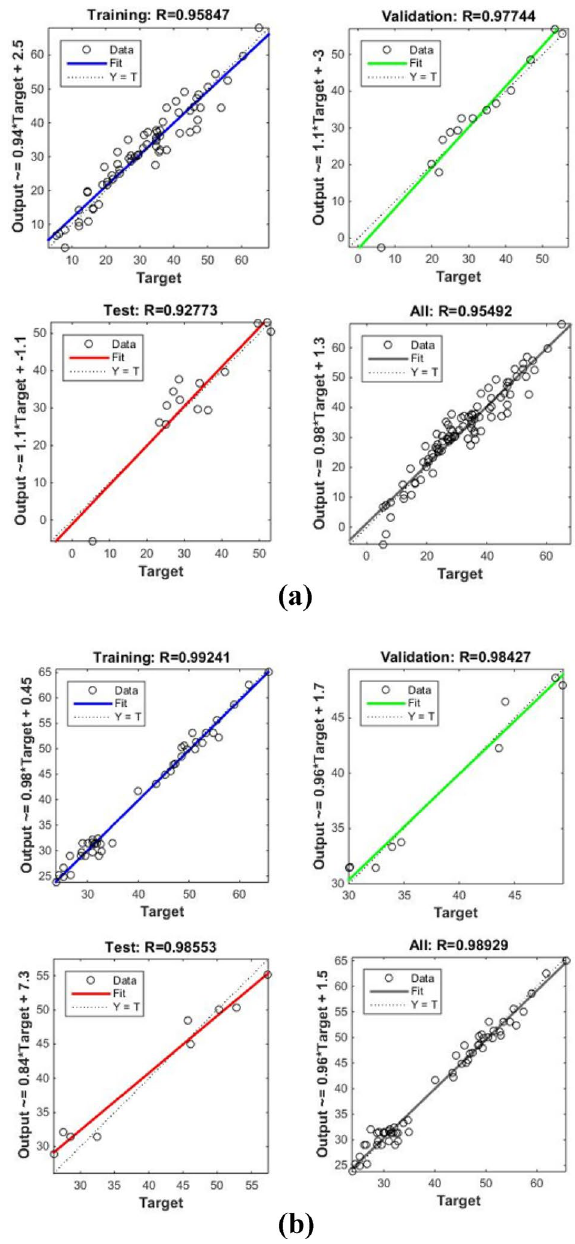
Figure 3. Regression Graphs for ANN models. ( a ) Model 1. ( b ) Model